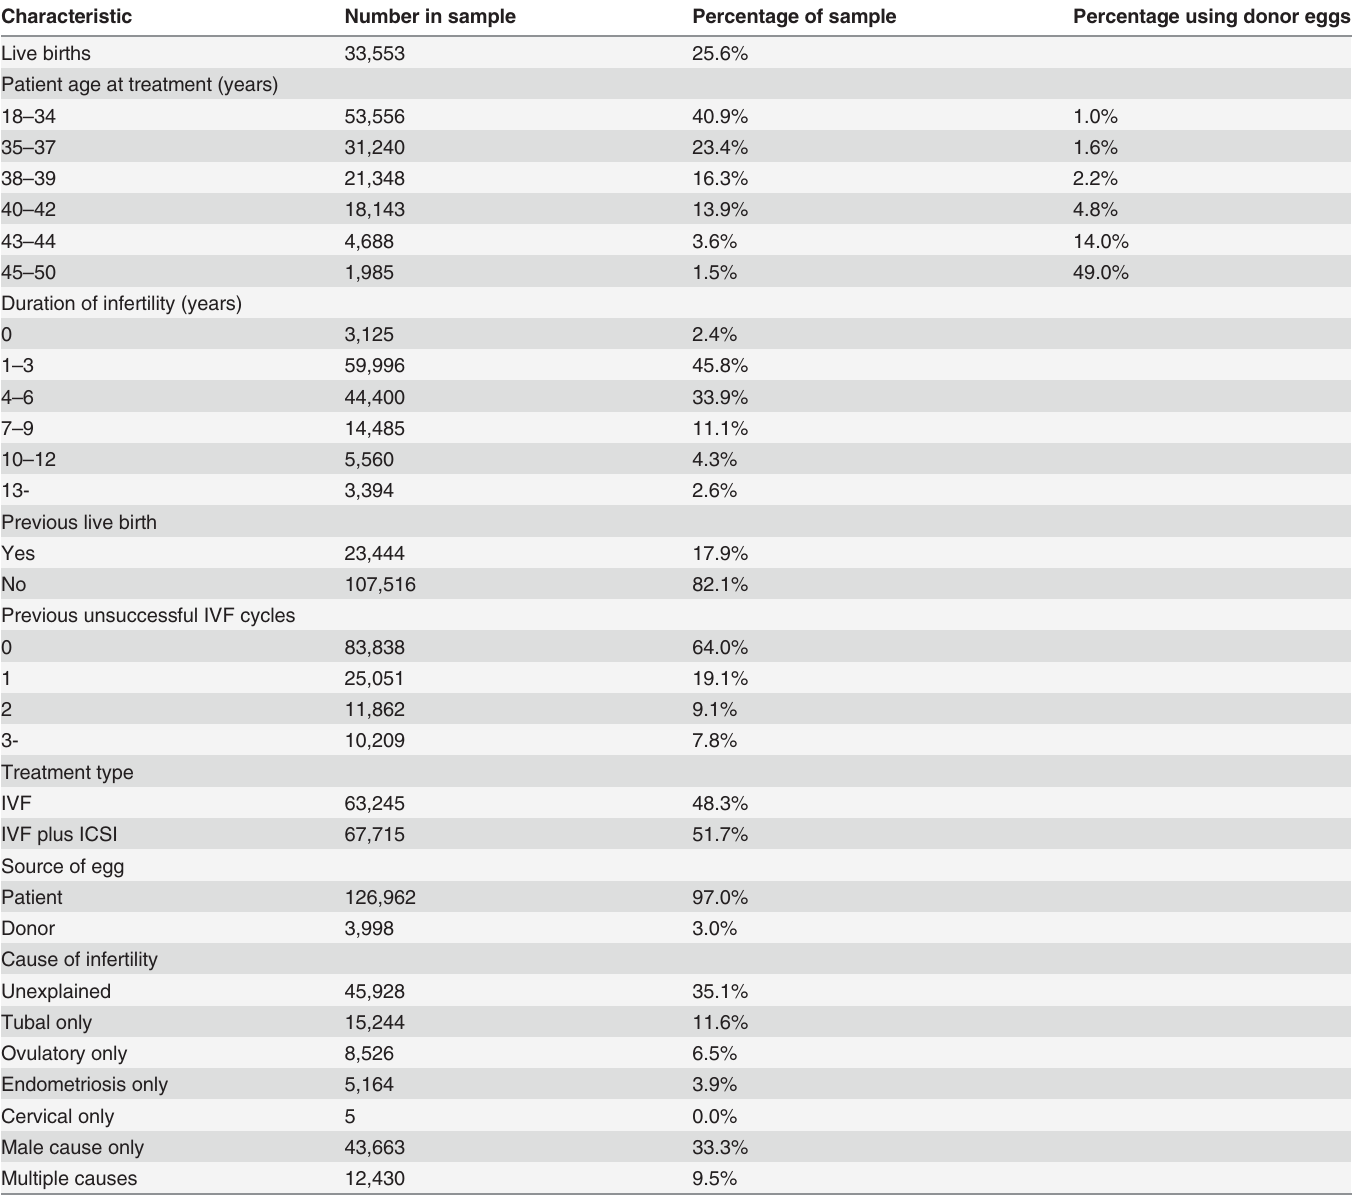
Table 1. Characteristics of patients and treatment in the validation sample, consisting of 130,960 IVF